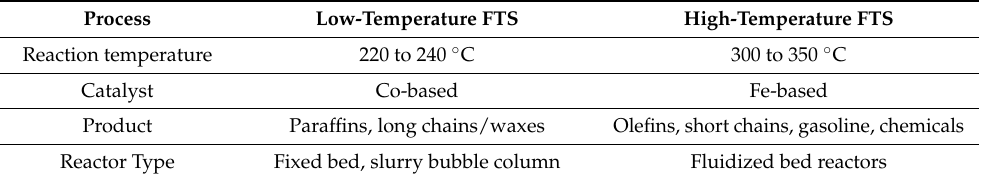
Table 1. Overview Fischer-Tropsch synthesis (FTS) applications in industry. Process Low-Temperature FTS Reaction temperature 220 to 240 ◦ C Catalyst Co-based Fe-based Product Paraffins, long chains/waxes Olefins, short chains, gasoline, chemicals Reactor Type Fixed bed, slurry bubble column Fluidized bed reactors FTS is strongly exothermic [15]. The reaction can be described via the